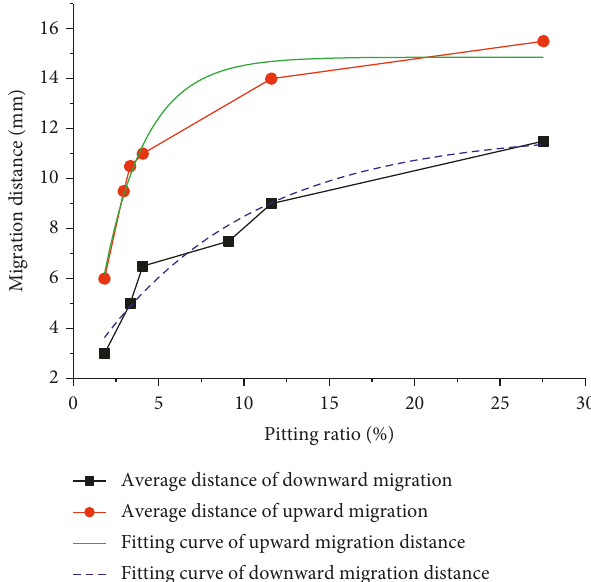
Figure 10: Migration distance contrast diagram in different